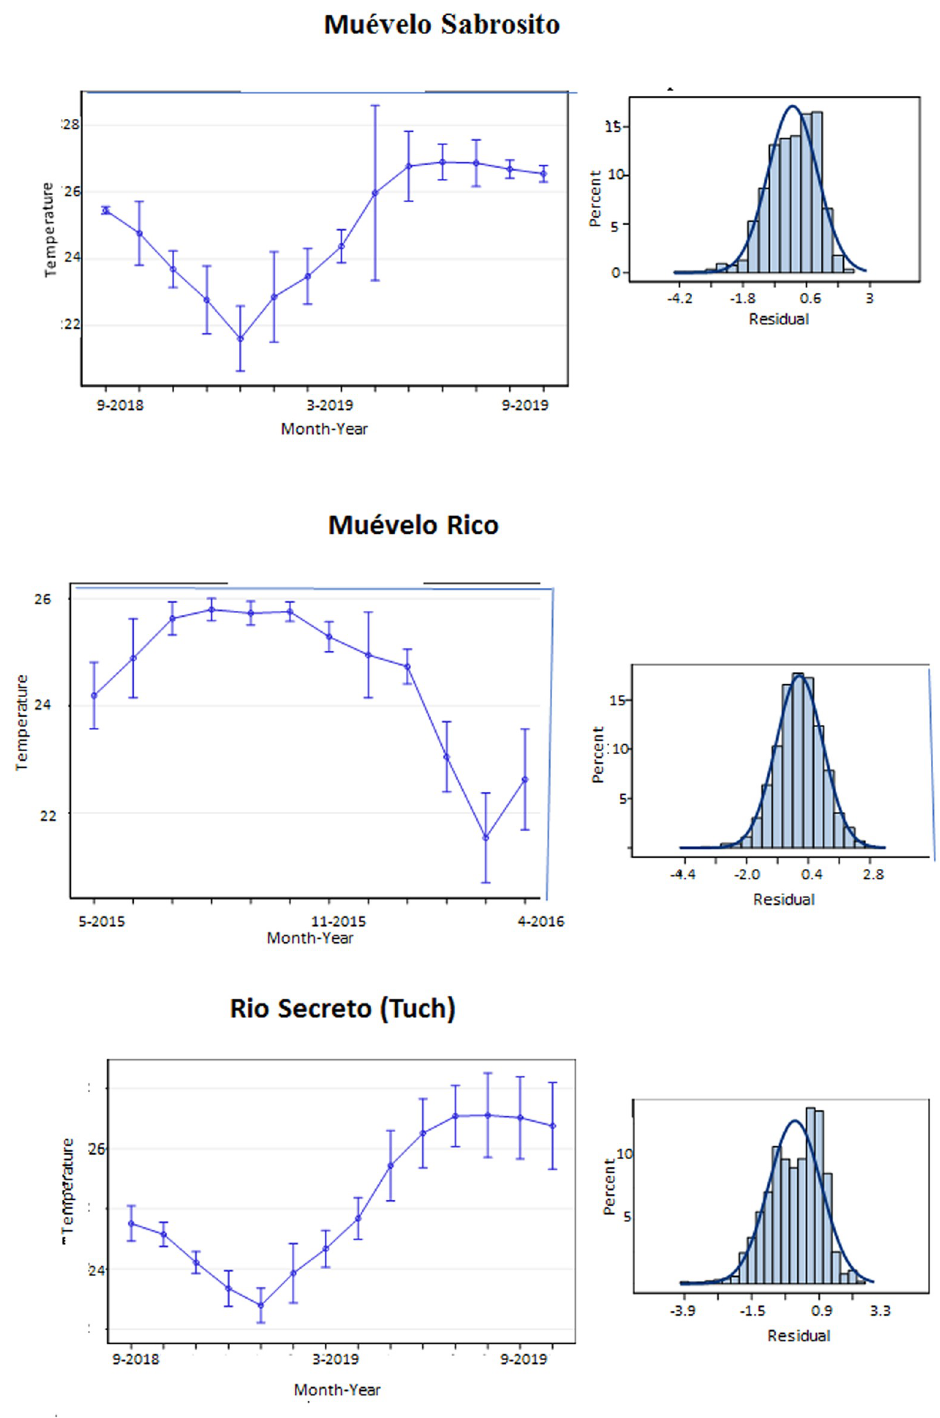
Fig 5. Least Square Means for temperature estimated in the GLM. Left panels are estimates of mean temperature with 95% confidence intervals. Note that the graph for Sistema Mue´velo Rico begins at a different month. The entrance station for Sistema Mue´velo Rico is not included. Right hand panels are plots of the residuals, compared to a normal distribution.